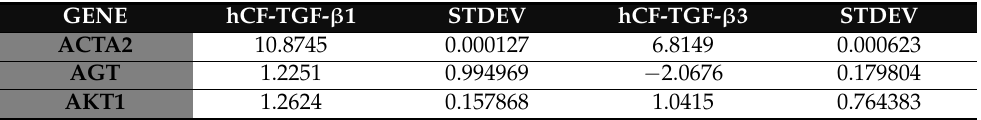
Table A1. List of genes expression level relative to untreated human corneal fibroblast constructs on RT 2 Profiler PCR Array for Fibrosis and Wound Healing array (Qiagen). Total RNA was extracted from human corneal fibroblast (hCF) 3D constructs that were either untreated or treated continuously with TGF- β 1 or TGF- β 3 for 4 weeks, subjected to cDNA synthesis, and analyzed with human Fibrosis and Wound Healing PCR Array. Expression of 86 genes from hCF + TGF- β 1 or hCF + TGF- β 3 relative to untreated hCF constructs is shown as fold change. Data are shown as average fold change with standard deviation (STDEV). N/A: not